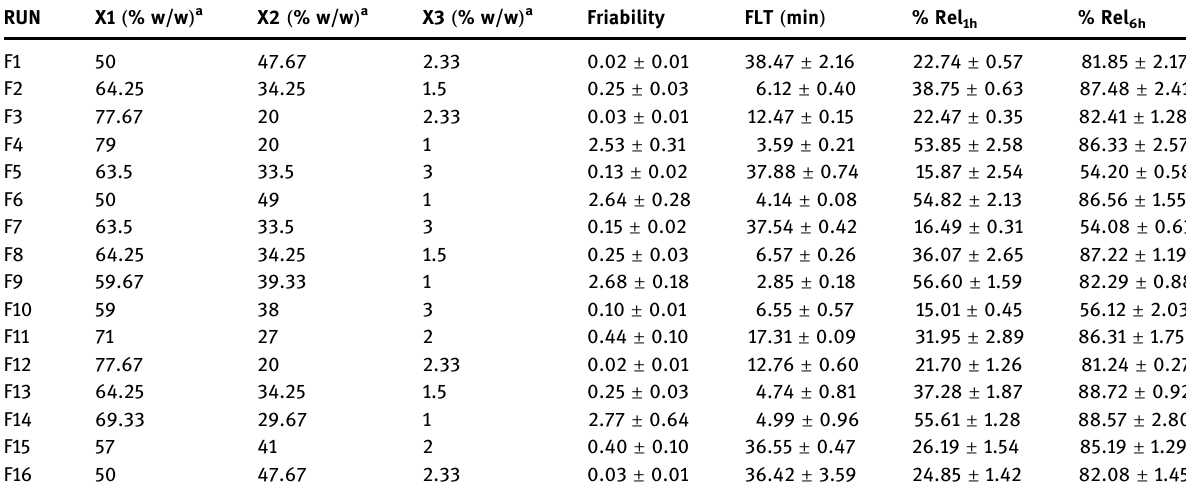
Table 3: Response parameters of the model formulations of fl oating bilayer tablets of CC prepared as per D - optimal mixture design RUN